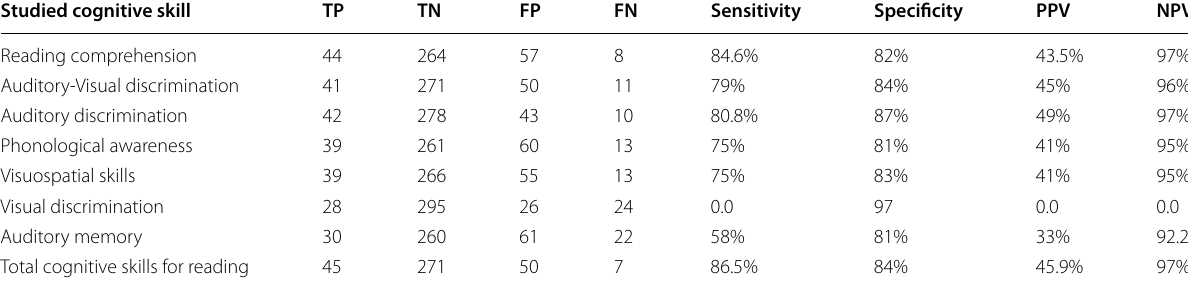
Table 3 Diagnostic validity of